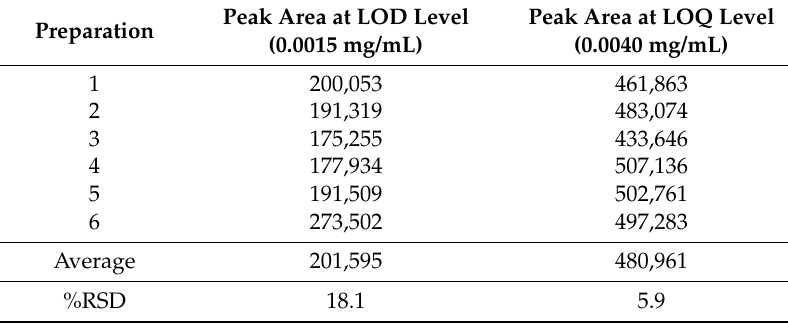
Table 1. Precision at LOD and LOQ levels of Eudragit ® L100.